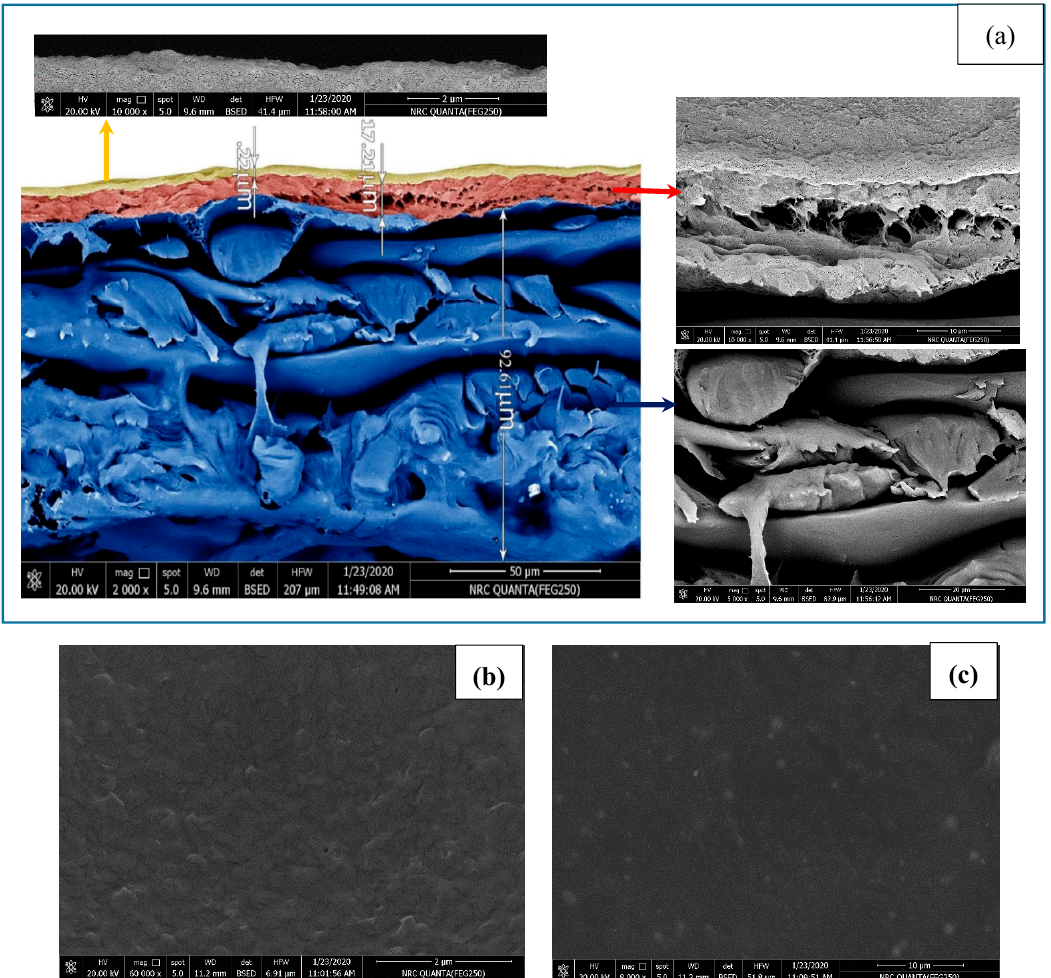
Figure 3. ( a ) Cross-section of an RO membrane, ( b ) surface morphology before oily wastewater treatment, and ( c ) surface morphology after oily wastewater treatment.